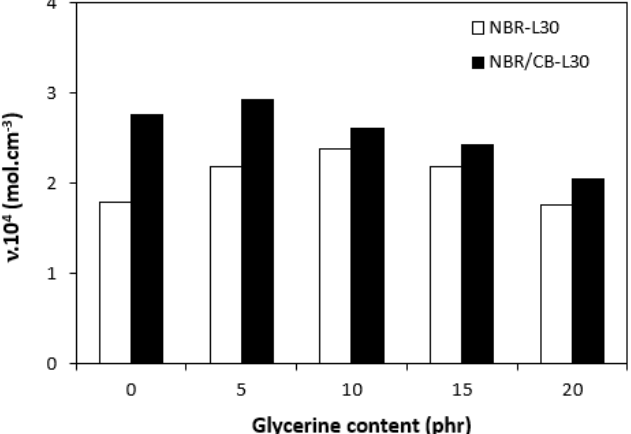
Figure 9. Influence of glycerine contents on cross-link densities υ of vulcanizates.